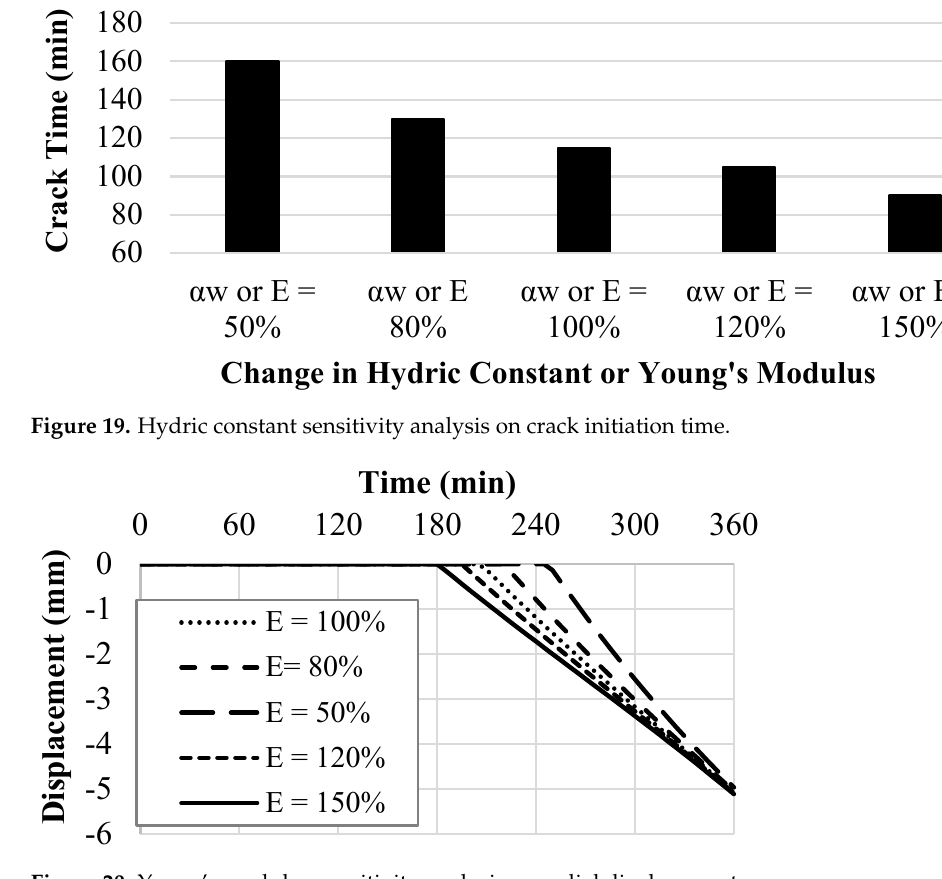
Figure 20. Young’s modulus sensitivity analysis on radial displacement.